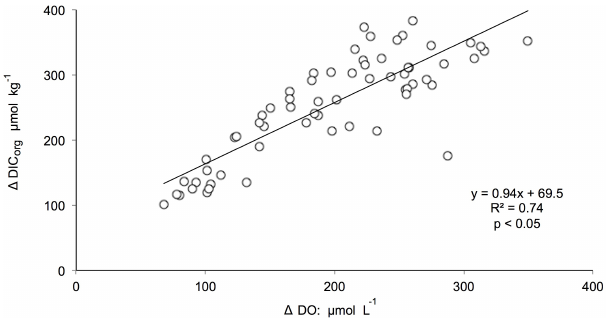
Figure 4. A linear correlation between calculated changes in dis- solved inorganic carbon ( (cid:49) DIC org : µmolkg − 1 ) as a function of measured changes in dissolved oxygen ( (cid:49) DO: µmol L − 1 ) over each 12h sampling period from all chambers and incubations. To exam- ine the variation in DIC due solely to photosynthesis and respiration (DIC org ) , changes in DIC were corrected for calcium carbonate pre- cipitation/dissolution using the measured changes in total alkalinity ( A T ; 0.5mol CO 2 :1mol A T )